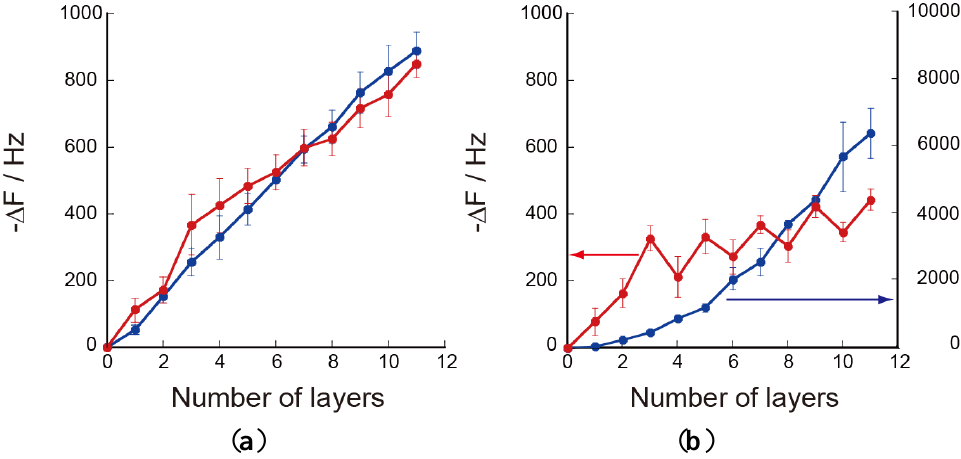
Figure 2. Frequency changes in the quartz-crystal microbalance (QCM) for deposition of ( a ) PEI(CHI/PVS) films; and ( b ) PEI(CHI/PAA) films at pH 3.0 (blue) and pH 7.0 (red). 5 n Plotted points are averages of three measurements with standard deviation.